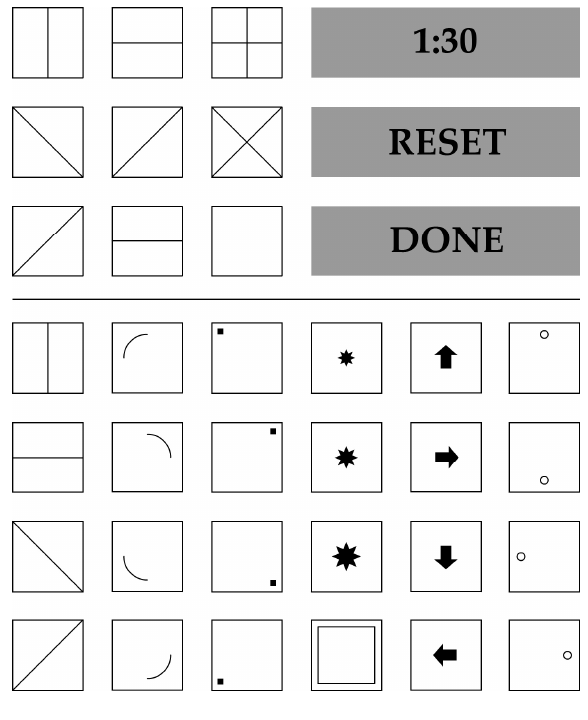
Figure 3. Construction task.